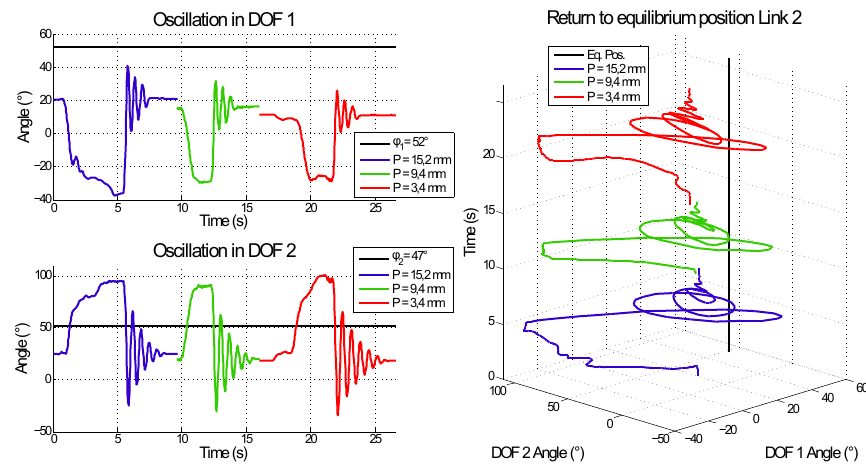
Figure 13. Induced passive oscillations for equilibrium position ( φ different